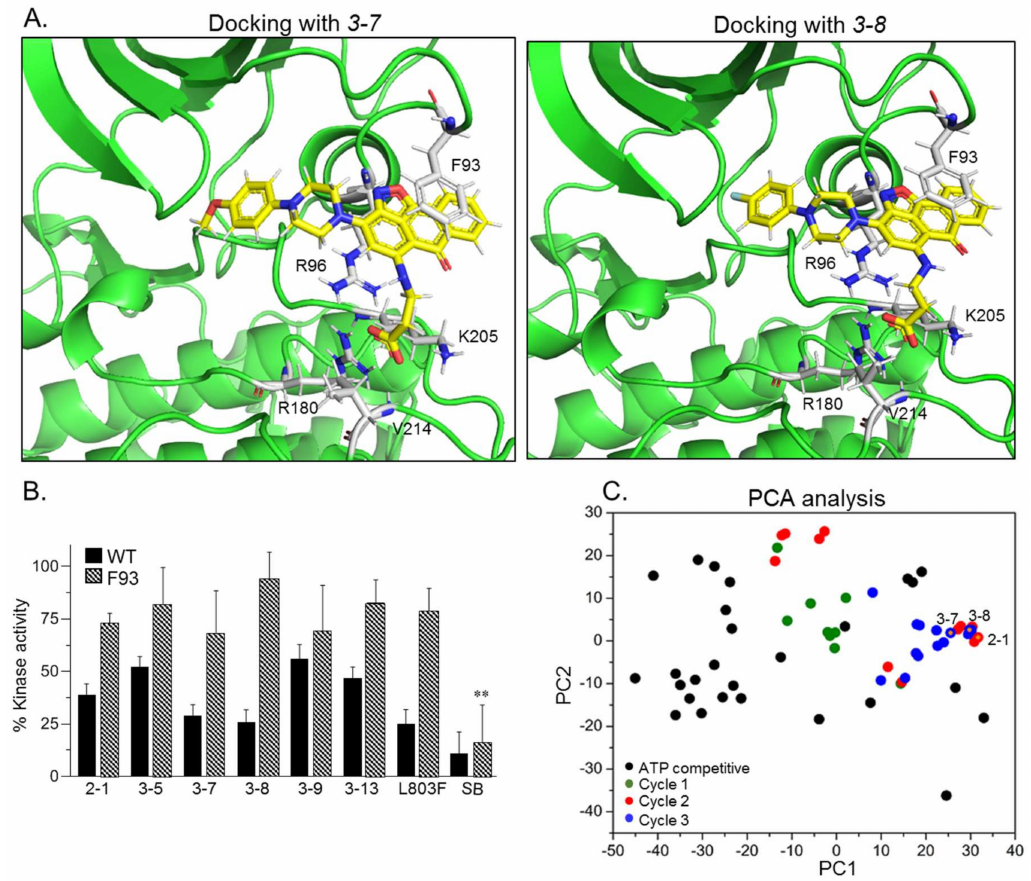
Figure 3. GSK-3 SCI compounds interact with the kinase substrate binding site and are chemically unique. ( A ) Docking models of compounds 3-7 and 3-8 with GSK-3 β . Key interacting GSK-3 β residues are highlighted, and detailed interactions are summarized in Table 1. The carboxylic acid moiety form salt bridges and H-bonding with the GSK-3-phosphate-binding pocket, Arg 96, Arg 180, Lys 205, and with Val 214. The anthracenone–isoxazole core forms π – π stacking interactions with Phe 93. Interactions were analyzed by the Maestro software. ( B ) In vitro kinase assays were performed with GSK-3 β (WT) or with the F93A mutant in the presence of indicated compounds, L803F (20 µ M each), and SB216763 (1 µ M). Results are mean of three independent experiments ± SEM analyzed by one way ANOVA with Dunnett’s multiple comparisons. ** p < 0.01 with inhibitor vs no inhibitor ( C ) Principal component analysis (PCA) analysis of all compounds discovered through the three search cycles together with representative GSK-3-ATP competitive inhibitors (listed in Table S4). The first and second PCs accounted for 81.8% and 7.7% of the original variance and are shown at the X- and Y -axis respectively. Black circles represent the ATP competitive inhibitors, colored circles represent compounds from cycle 1 (green), 2 (red) and 3 (blue). Circles with yellow dots represent compounds 2-1 , 3-7 and 3-8